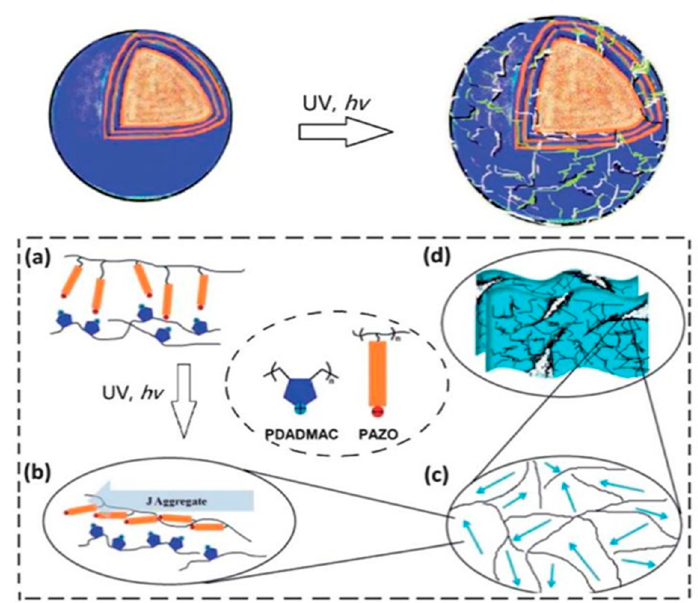
Figure 4. Schematic illustration of (PDADMAC/PAZO) microcapsule disruption induced by UV irradiation [55]: ( a ) LbL assembly of the polyelectrolytes on the capsule shell surface; ( b ) formation of J aggregates under UV irradiation; ( c , d ) extended aggregates act as stress raisers, triggering capsule breakage. Reprinted with permission from [55]. Copyright 2014 Royal Society of Chemistry.